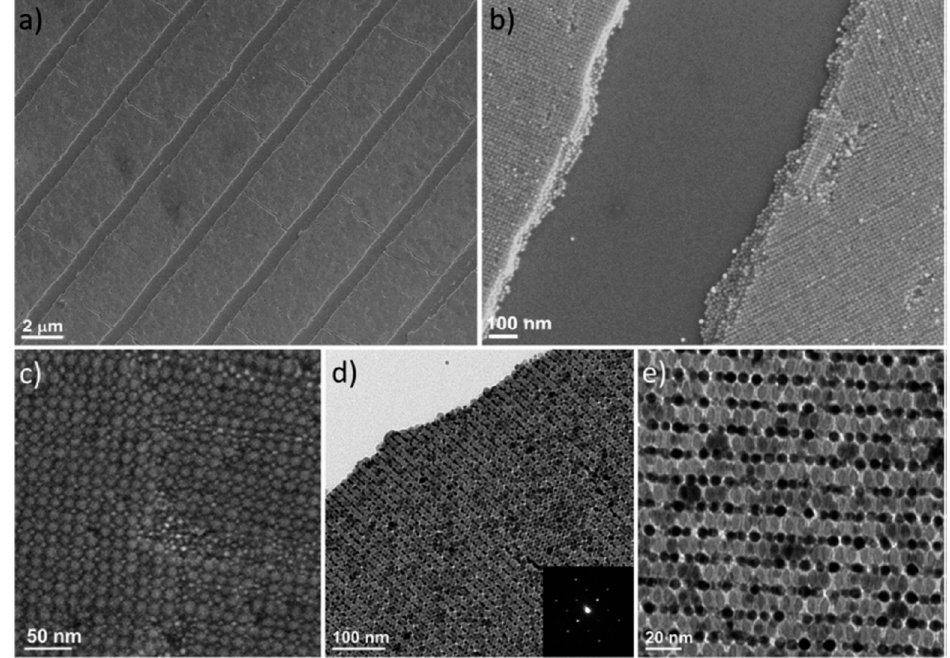
Figure 7. Hierarchical BNSL nanostructures formed by liquid–air interfacial assembly and transfer printing. ( a – c ) SEM images, and ( d ) low-magnification (inset: selected-area electron diffraction pattern) and ( e ) high-magnification TEM images of patterned AlB 2 BNSLs assembled from FeOx and Au NCs (Reproduced with permission from [37]. Copyright American Chemical Society, 2017).